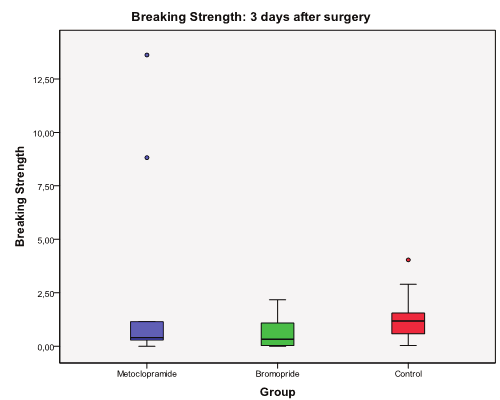
FIGURE 1 - Distribution of abdominal wall wound breaking strength (expressed in newtons) three days after surgery. Group M (metoclopramide) shown in blue, group B (bromopride) shown in green, and group C (control) shown in red. Solid circles above the box plot and printed in the same color represent outliers.